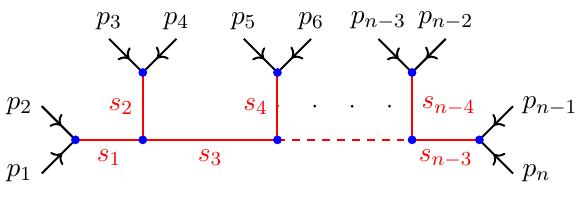
Figure 4. Auxiliary momenta and Mandelstam variable assignments: graphical representation of n - point conformal blocks in the OPE channel from figure 1c with auxiliary momenta and Mandelstam variables